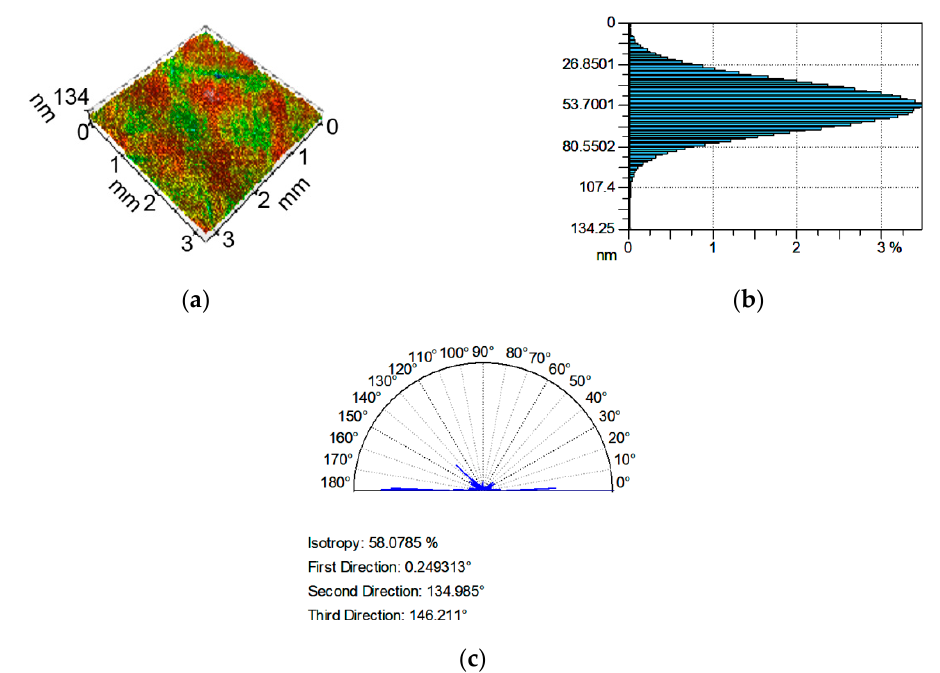
Figure 3. Isometric view ( a ), ordinate distribution ( b ), and directionality plot ( c ) of surface texture after polishing.